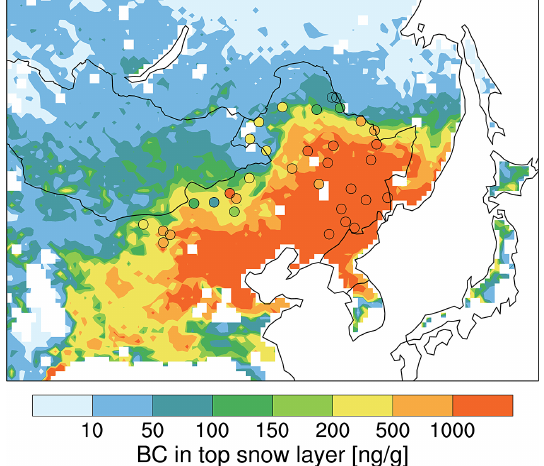
Figure 5. Spatial distribution of BC mass concentration in the top snow layer from the WRF-Chem simulations over North China in January–February 2010. The campaign observed BC mass concen- trations in the top snow layer (colored circle) are also shown.